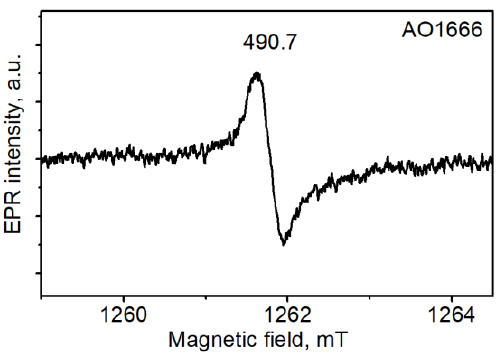
Figure 4. Electron paramagnetic resonance (EPR) spectrum of the AO1666 plate measured at room temperature.